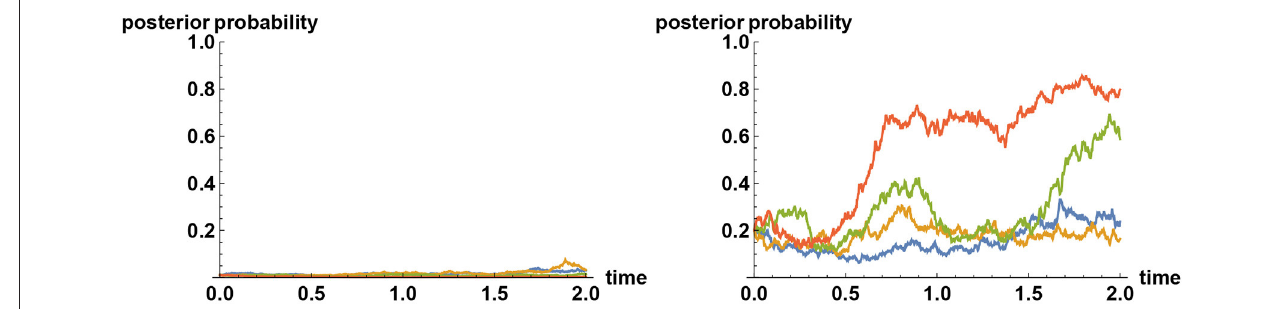
FIGURE 3 | Tenacious Bayesian behavior in a binary decision making. The two alternatives are represented by the values X “correct” decision is preselected to correspond to the choice X a priori probability for the incorrect decision X not the correct choice, the decision makers in these simulations have hardly changed their views even after 2 years, in spite of following the Bayesian logic. In contrast, if the prior probability for the incorrect choice X there will be more variabilities, as shown on the right